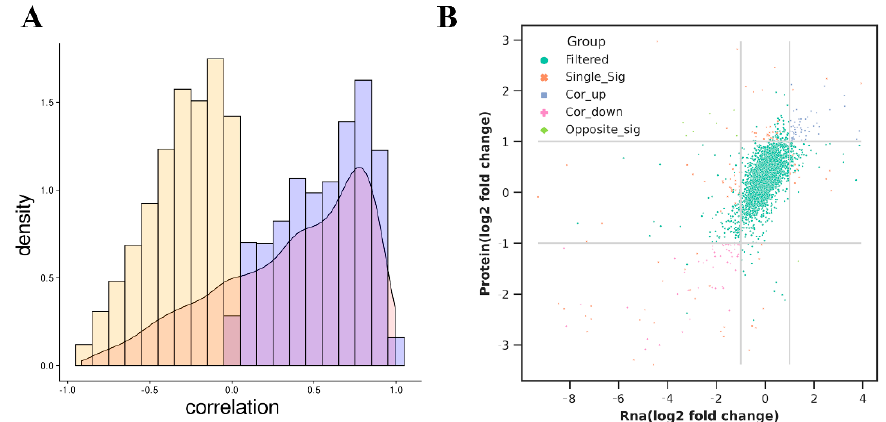
Figure 7. Integration analysis. The differential genes and differential proteins were analyzed together. ( A ) presents the correlation between DEGs and DEPs. ( B ) presents the nine-quadrant dia- gram.